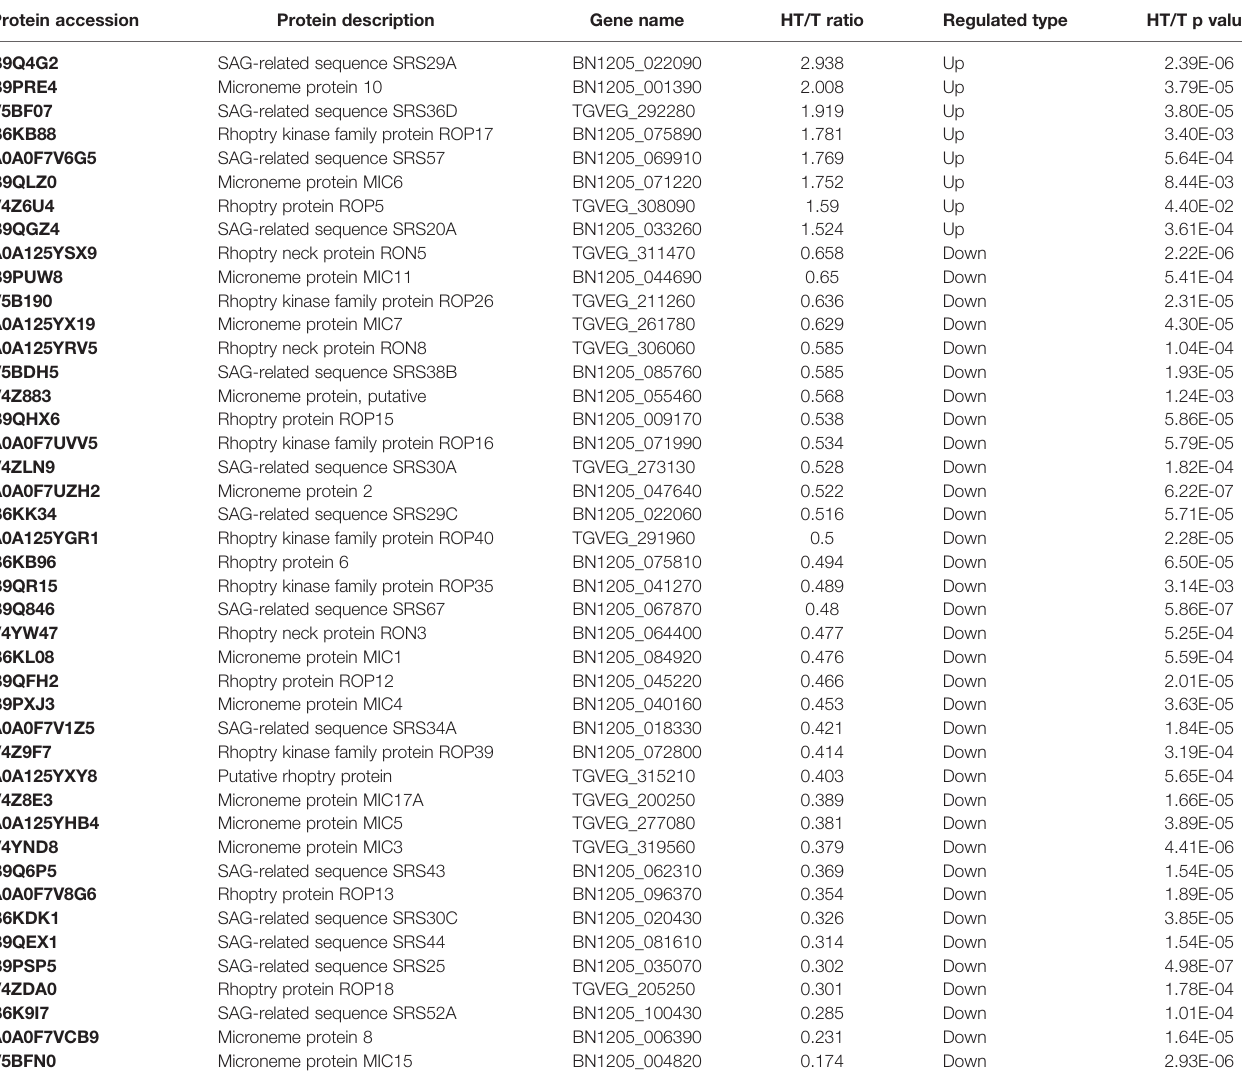
TABLE 1 | Details pertaining to differentially expressed secretory proteins. Protein accession Protein